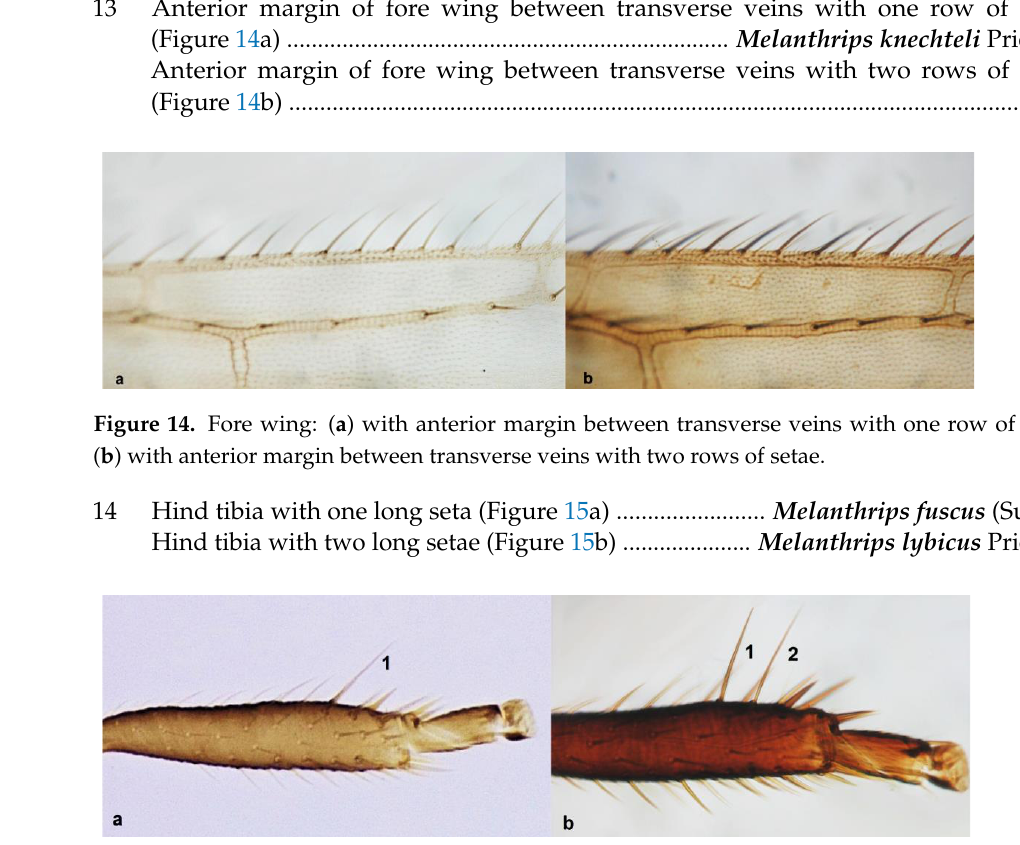
Figure 13. Fore wing: ( a ) banded; ( b ) not banded.